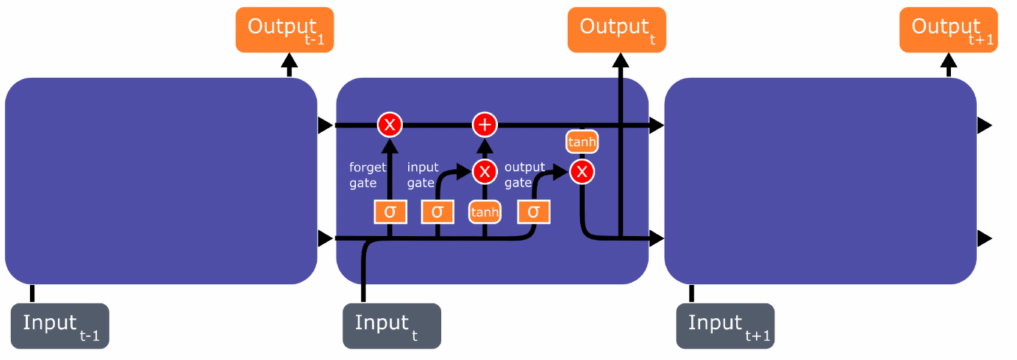
Figure 3. Basic Long Short-Term Memory (LSTM) model